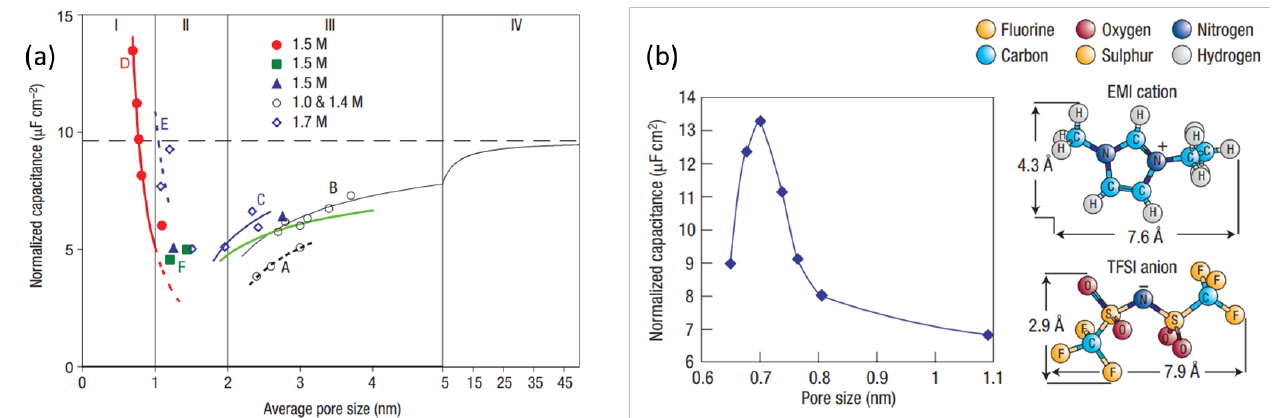
Figure 8. ( a ) Specific capacitance normalised by SSA as a function of pore size for different carbon samples, all tested in the same electrolyte (NEt 4 BF 4 in acetonitrile; concentration given in key). The symbols show experimental data (A, B: templated mesoporous carbons; C: activated mesoporous carbons; D, F microporous CDC; E: microporous activated carbon) and the trend lines show model fits [38]. ( b ) Normalised capacitance change as a function of the pore size of CDC samples, with inset showing the structure and size of the electrolyte ions. Adapted with permission from Ref. [38]. 2009, World